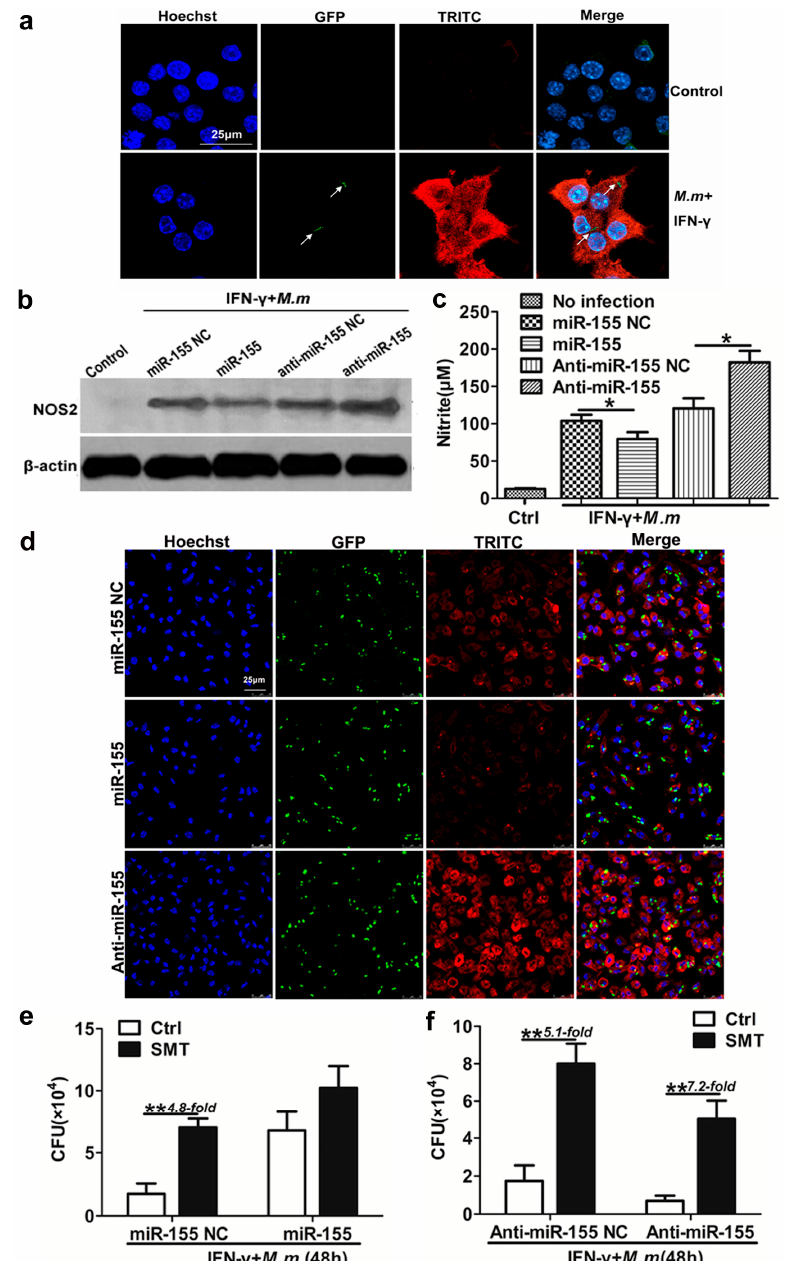
Figure 3. miR-155 promote M.m survival in macrophages by inhibition of NO. ( a ) NOS2 expression in the cytoplasm of RAW 264.7 cells. The co-localization of GFP-labeled M.m (green) and TRITC-labeled NOS2 (red) in the cytoplasm was examined by confocal microscopy. Arrows indicate M.m . Nucleus of RAW 264.7 cells were stained with Hoechst (purple); ( b ) Immunoblot blot analysis of NOS2 in RAW 264.7 cells; ( c ) NO synthesis in RAW 264.7 cell. Cells were transfected with miR-155 NC, miR-155, anti-miR-155 NC and anti-miR-155 followed by IFN- γ treatment and infected with M.m for 24 h, supernatant nitrite was determined by the Griess test; ( d ) NOS2 expression in the cytoplasm of MPM cells. Cells were transfected with miR-155 NC, miR-155, anti-miR-155, and infected with GFP-labeled M.m /IFN- γ for 24 h. The co-localization of M.m (green) and TRITC-labeled NOS2 (red) in the cytoplasm were detected by confocal microscopy. Nucleuses of MPMs were stained with Hoechst (purple); ( e , f ) The effect of miR-155, anti-miR-155 and NOS2 inhibitor on M.m survival in RAW 264.7 cells. Cells were transfected with miR-155, anti-miR-155 and corresponding NC, pretreated with 1 mM SMT for 2 h, infected with IFN- γ / M.m for 48 h. Intracellular M.m survival was determined by CFU assay. Data are shown as the means ± SEM of three independent experiments, * p < 0.05, ** p < 0.01.